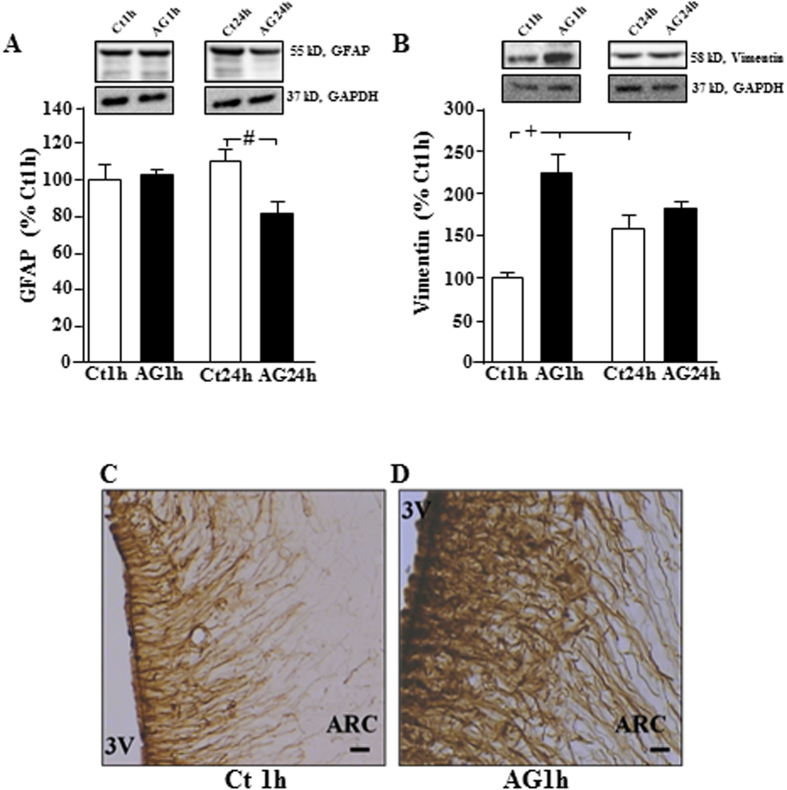
Effect of acyl-ghrelin treatment on glial structural proteins.Hypothalamic levels of (A) GFAP and (B) vimentin at 1 and at 24 hours (h) after icv injection of acyl-ghrelin (AG, 2 μg). Immunohistochemistry for vimentin showed increased labeling in the hypothalamus of (C) control and (D) AG treated rats. 3 V = 3rd ventricle, ARC = arcuate nucleus. #p < 0.01, +p < 0.005. Representative Western blots are from the same gel although samples were not contiguous within the gel.